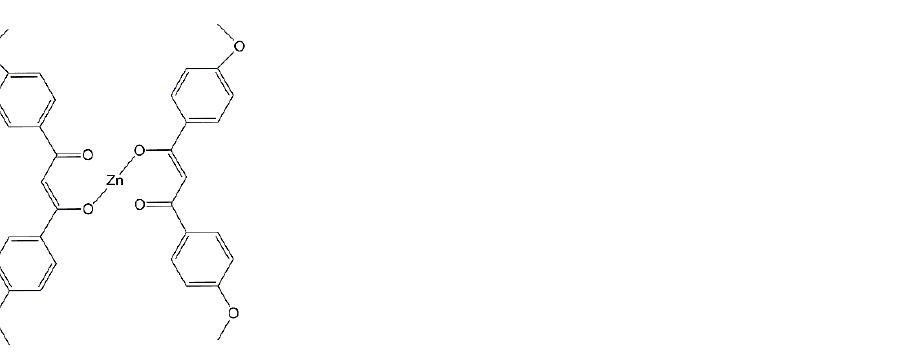
Figure 3. Structure of zinc 1,3-bis-( 4′ methoxyphenyl)propane-1,3-dione (MMBPP-Zn).